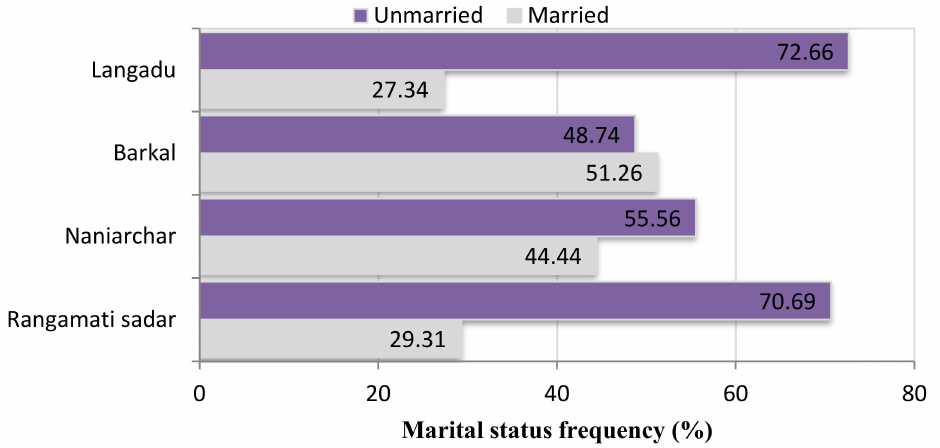
Figure 3. Marital status of the fishers in the study areas of Kaptai Lake.